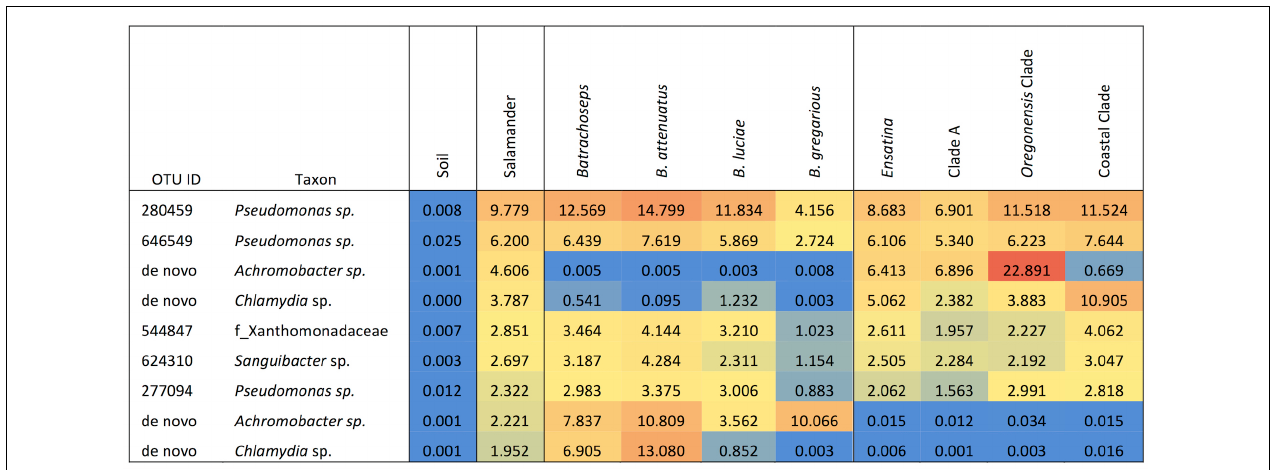
FIGURE 2 | Heat map of the relative abundances as percent values of dominant OTUs ( ≥ 3% of microbiome composition) for each sample type, genus, species and Ensatina higher clade groups.